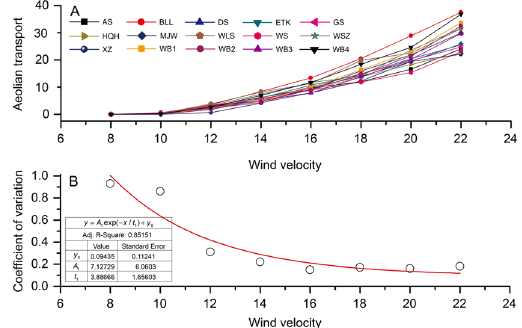
Figure 3. Average aeolian transport (g m 2 s − 1 ) ( A ) and the coefficient of variation ( CV , B ) in wind tunnel experiments under different wind velocities (m s − 1 ). The CV is expressed as = CV SD refer to the standard deviation and average, respectively.